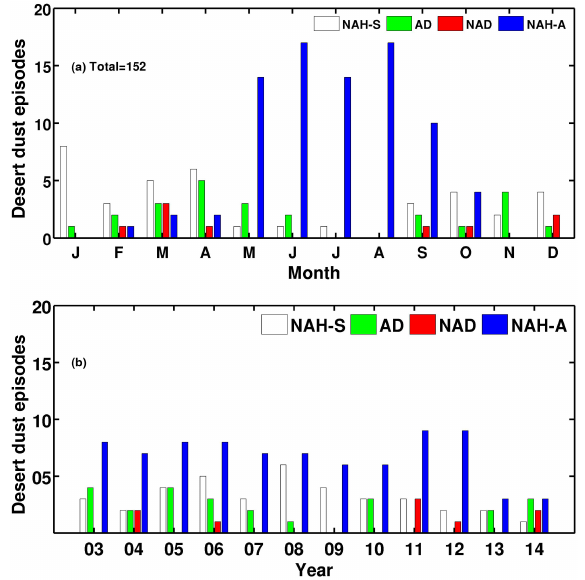
Figure 8. Annual cycle (a) and interannual (b) variability of DD episodes classified in terms of their synoptic scenarios: NAH-S (white bars), AD (green bars), NAD (red bars), and NAH-A (blue bars). The four synoptic scenarios are described in the text (see Sect.